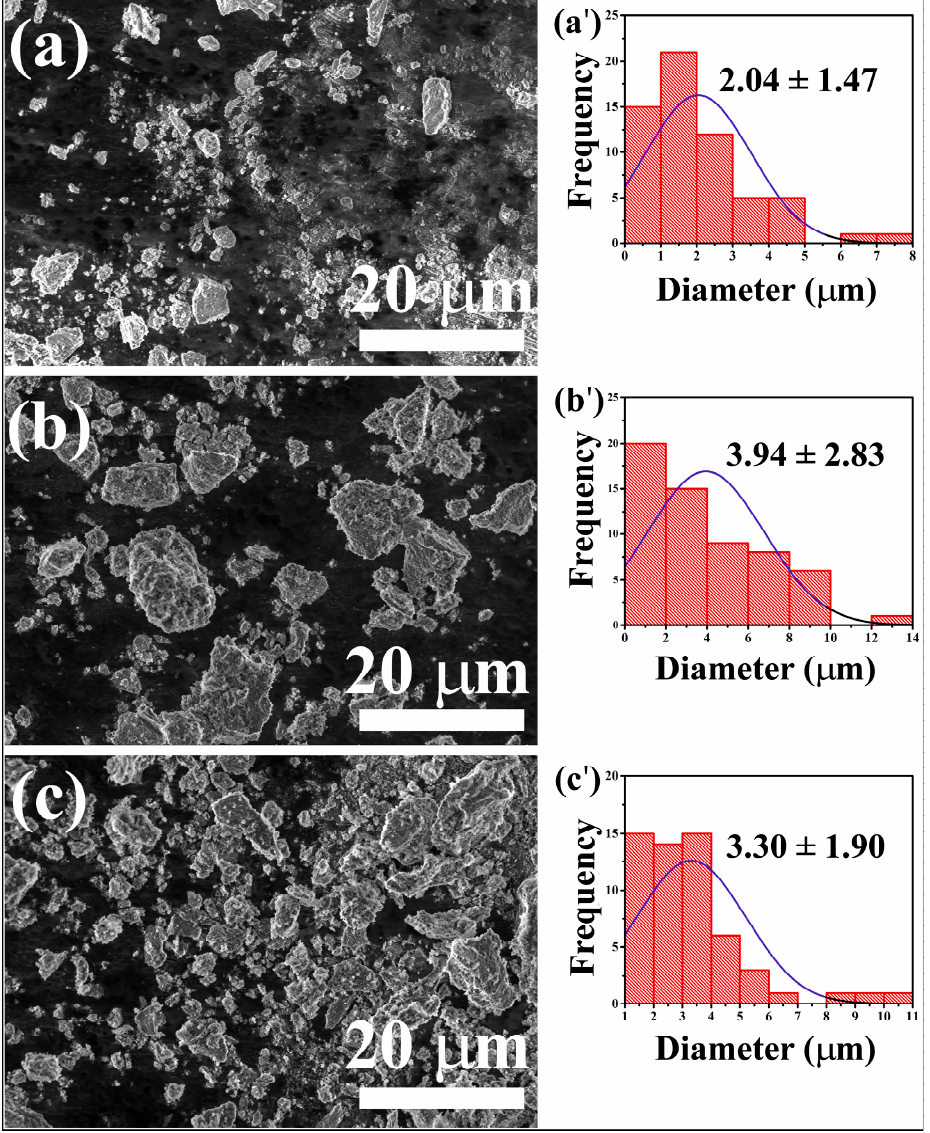
Figure 3 . SEM images of ZnAl 2 O 4 :M (M = Co 2+ and Co 2+ /Nd 3+ ) pigments: ( a ) ZnAl 2 O 4 , ( b ) Co-Gahnite, and ( c ) CoNd-Gahnite. The corresponding images ( a ′ ), ( b ′ ), and ( c ′ ) are related to the particle size aglomerates distribution histograms of the pigments. To study the electronic structure of the major elements, near-surface region, the high energy resolution photoelectron spectra of Zn 2p and Al 2p core levels are shown in Figure 4; the spectra were calibrated based on the reference peak of C 1s at 284.6 eV from carbon contamination. The Zn 2p 3/2 XPS spectra were deconvoluted into two components, appearing in the range 1020–1021 eV and 1022–1023, assigned to the tetrahedrally (Td)